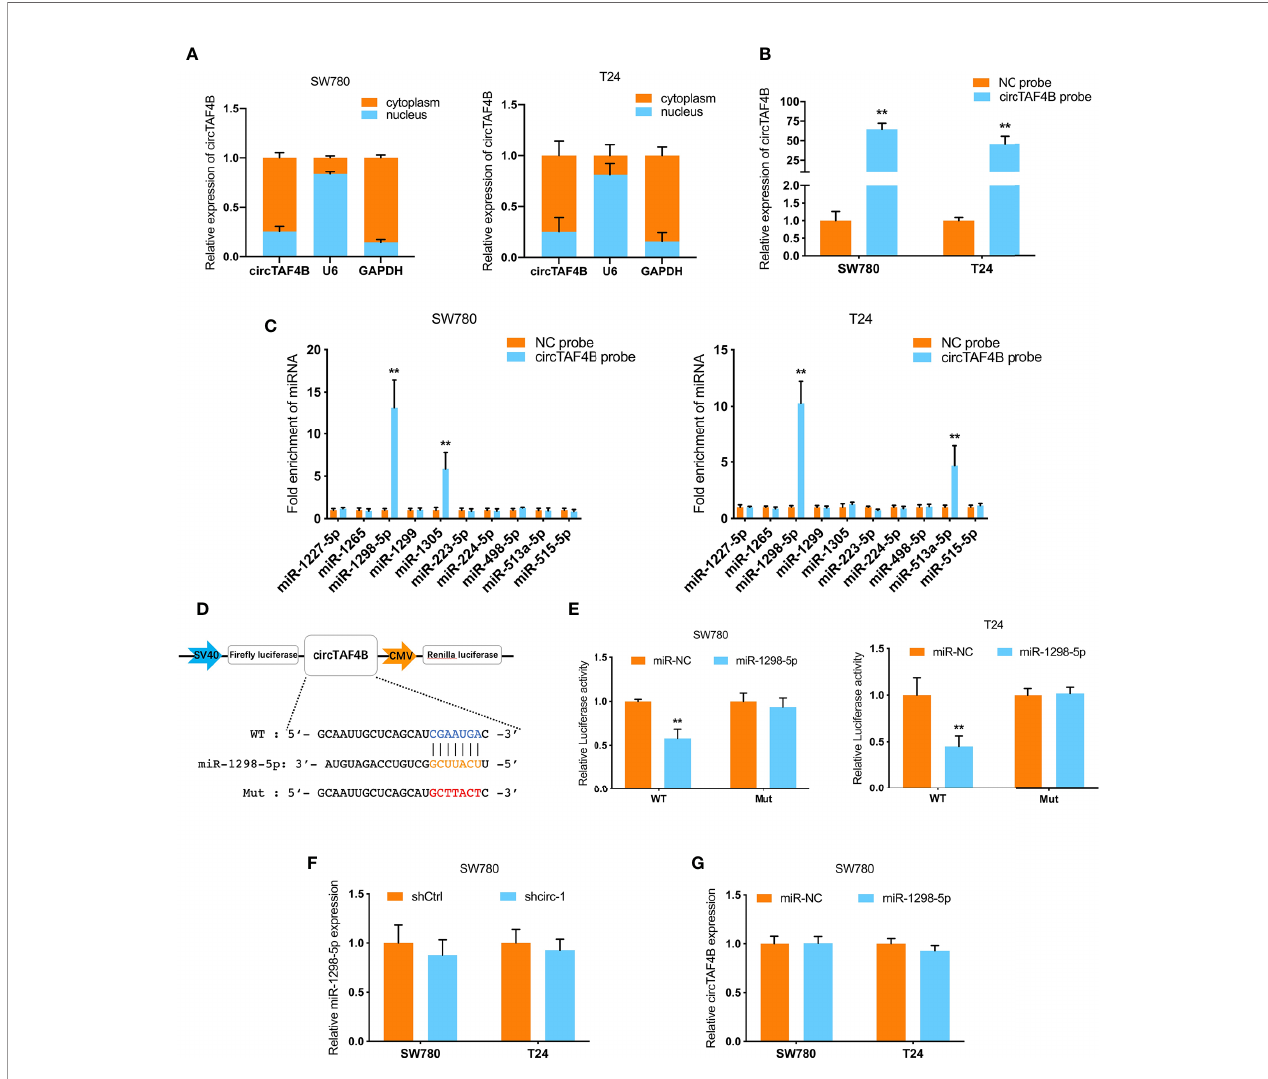
FIGURE 4 | circTAF4B sponges miR-1298-5p. (A) The distribution of circTAF4B in the cytoplasm and nucleus was detected by nuclear/cytoplasmic fractionation experiments. (B) The ef fi ciency of the biotin-labeled circTAF4B probe was veri fi ed by qRT-PCR. (C) RNA pull-down assay showed that the enrichment of microRNAs was captured by the circTAF4B probe. (D) Schematic diagram of the dual-luciferase reporter plasmid targeting circTAF4B. (E) Luciferase activity was signi fi cantly decreased after cotransfection with circTAF4B wild-type (WT) and miR-1298-5p mimics. (F, G) qRT-PCR showed that knockdown of circTAF4B had no effect on the expression of miR-1298-5p, and miR-1298-5p overexpression had no effect on the expression of circTAF4B. Data represent the mean ± SD of more than three independent experiments. *p < 0.05; **p <